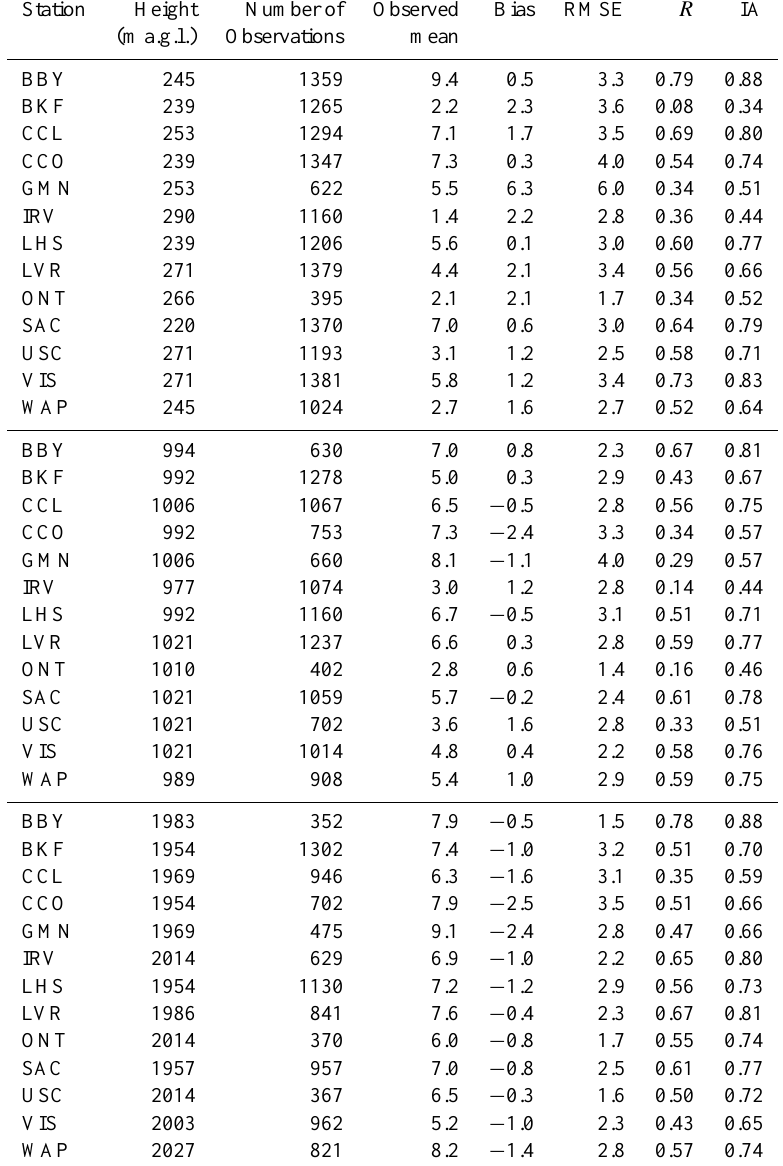
Table 6. Performance in simulated wind speed (ms − 1 ) in terms of bias, root-mean-square error (RMSE), correlation coefficient ( R ), and index of agreement (IA) for the radar wind profilers shown in Fig. 1c. Statistics given for range gates (measurements at discrete altitudes) close to ∼ 250, ∼ 1000, and ∼ 2000ma.g.l.. Statistics at TRK are not given because relatively little data were available May and June of